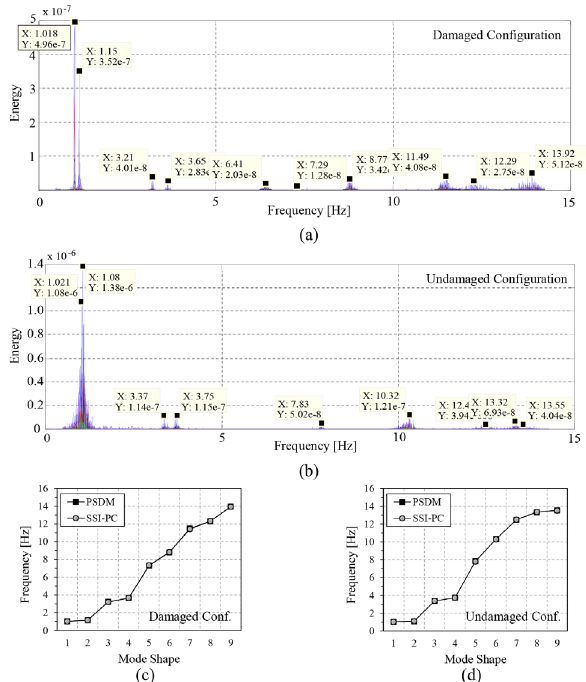
Figure 9. Eigenvalues plotting for (a) damaged state (before wor- ks) and (b) undamaged state (after works); and (c-d) eigenfrequen- cies comparison between PSD Method and SSI.